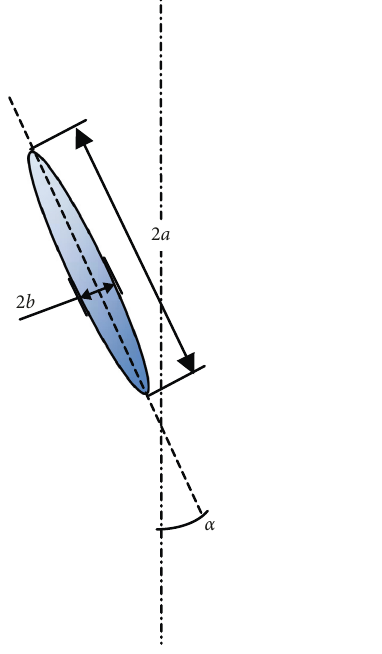
Figure 4: 2D elliptical contact